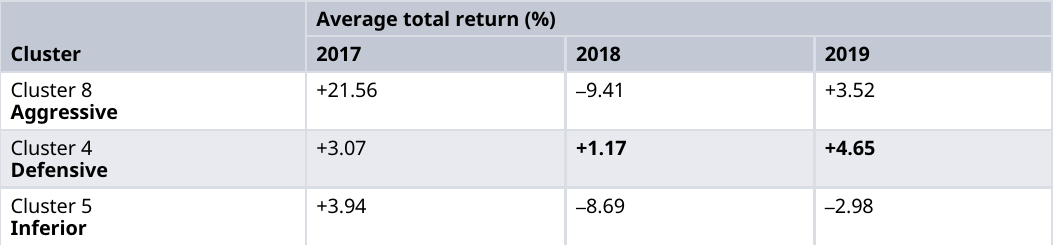
Table 6. Three identified clusters were evaluated using average total returns (%) in 2018 and